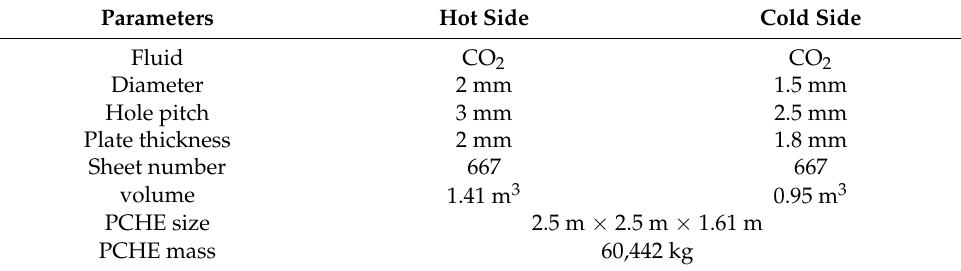
Table 1. Structural parameters of PCHE.